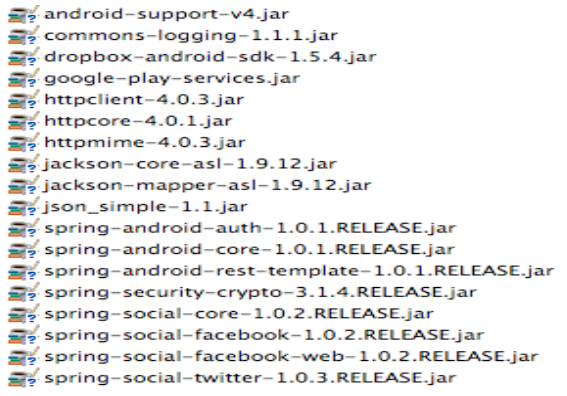
Figure 6. Screenshot from the Eclipse IDE of the required JAR files for the Android thin client for each service provider. Duplicated functionality can be seen; jackson JAR files are for JSON parsing, the json- simple JAR is required by another file but contains the same parsing functionality as